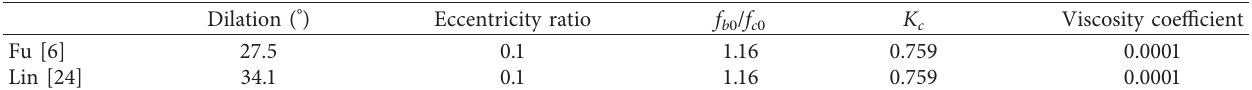
Figure 6: The FE models: (a) Fu [6] and (b) Lin [24]. Table 6: Parameter setting of